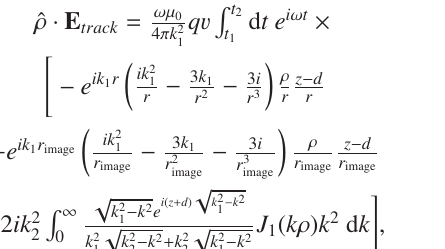
Figure 2. Two-dimensional colour plot of the total SDP maxi- mum amplitude as a function of the primary proton energy and Figure 1. Electric field (vertical component) as a function of shower zenith angle. time created by a 1 EeV proton-induced shower with 30 ◦ of zenithal angle. Times have been arbitrarily o ff set. One observer is placed at 200 m from the shower core and the other one at 500 m. The SDP is indicated by the arrows.